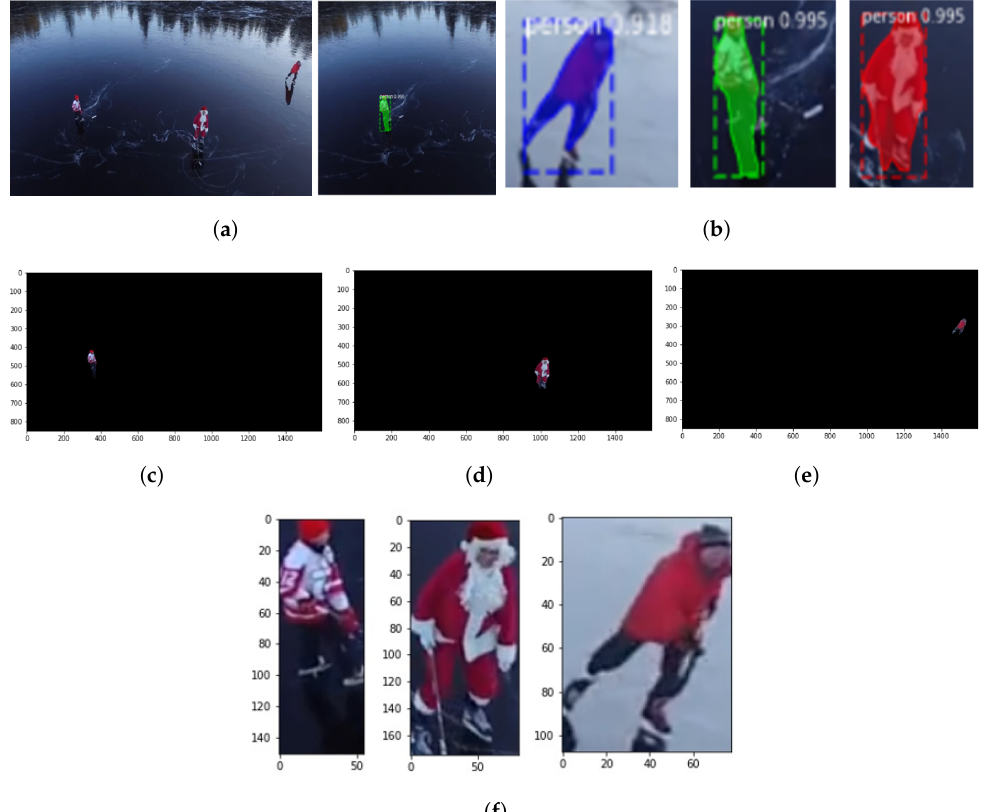
Figure 16. Outcomes of human segmentation using Mask-RCNN. ( a ) Original frame and masked frame. ( b ) Human images with masks and scores. ( c ) First human. ( d ) Second human. ( e ) Third human. ( f ) Segmented